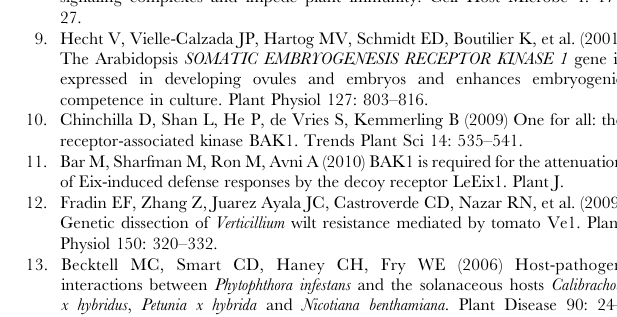
Figure S1 NbSerk3 variants are silenced by TRV:: NbSerk3 silencing construct. RT-PCRs were carried out on NbSerk3 - or control silenced leaf discs using primers that amplify a region which does not overlap with the silencing target sequence (A). Different amounts of total cDNA were subjected to PCR using control tubulin primers or NbSerk3 specific primers and visualised in an EtBr gel (B). (TIF) Figure S2 NbSerk3 silenced N. benthamiana shows enhanced susceptibility to infection by P. infestans T30-4 and EC1 isolates. N. benthamiana plants were silenced using tobacco rattle virus vectors harbouring green fluorescent protein gene that is not present in N. benthamiana (TRV:: GFP ) or a partial NbSerk3 sequence (TRV:: NbSerk3 ). Nineteen days later, leaves were detached and spore droplet inoculated within the dotted lines with P. infestans T30-4 (upper row) or EC1 (lower row). Images were taken 6 dpi with UV illumination. Dotted lines represent infected areas.